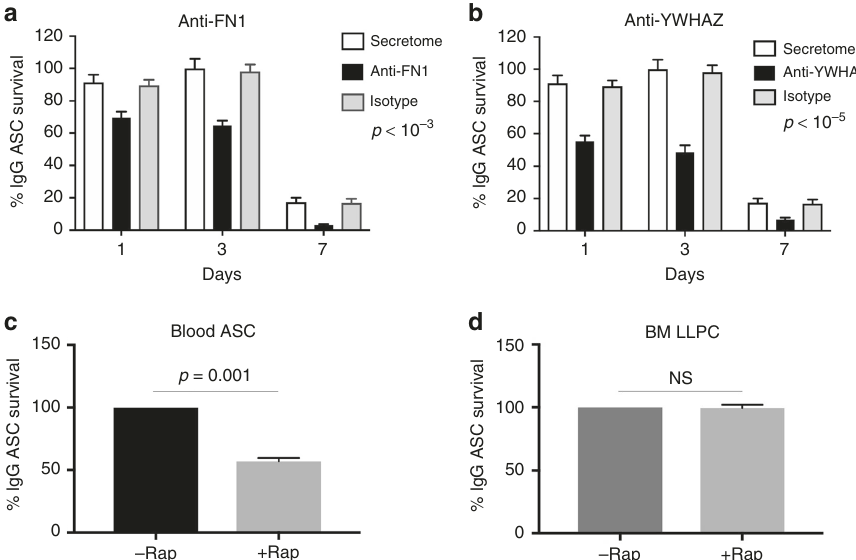
Fig. 5 Validation of ASC survival. Treatment of MSC secretome with antibodies targeting a FN-1 or b YWHAZ diminishes blood ASC survival. Blood ASC were cultured in MSC secretome alone (white bar) or MSC secretome treated with antibodies targeting FN-1 ( a ; black bar) ( p < 10 -3 ; linear regression modeling using media (secretome) as a covariate) or YWHAZ ( b ; black bar) ( p < 10 -5 ; linear regression modeling using media (secretome) as a covariate), or appropriate isotype controls (gray bar). Graph represents average of at least three experiments. Sensitivity and resistance to Rapamycin in c blood ASC and d BM LLPC. Blood ASC from three healthy subjects or BM LLPC from three adults were sorted and cultured in untreated MSC secretome (black bar) or MSC secretome treated with rapamycin (gray bar). The frequency of vehicle controls (DMSO) was comparable to that of untreated MSC secretome. p = 0.001; ANOVA) ( c ); NS, non-signi fi cance ( d